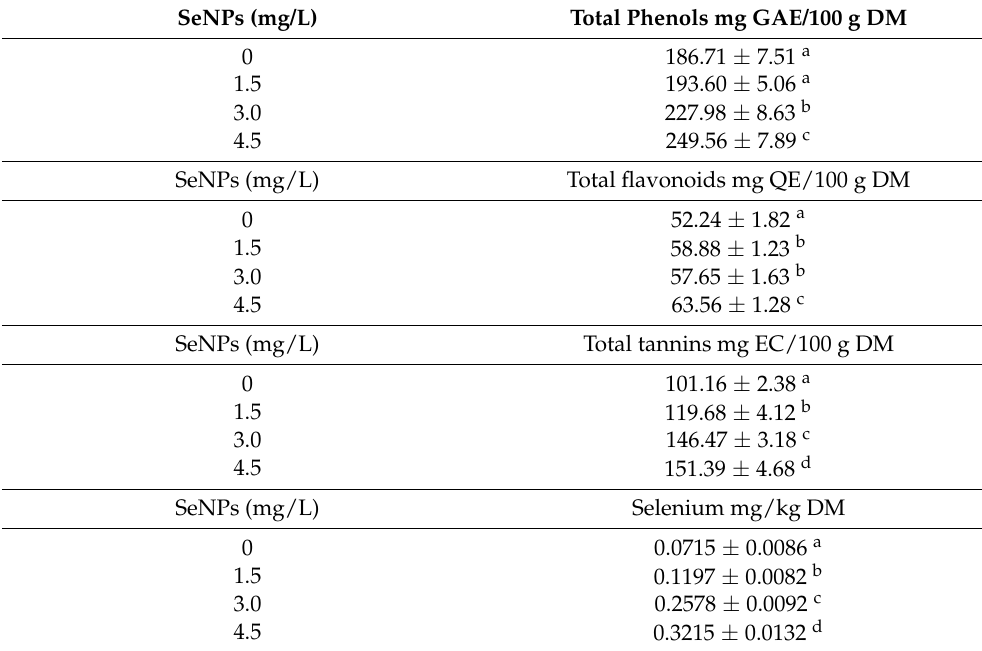
Table 3. Content of total phenols, flavonoids, total tannins, and selenium in the different treatments of foliar-biofortified grass ( Festuca arundinacea Schreb. ) with different concentrations NPs of Se during the different times of